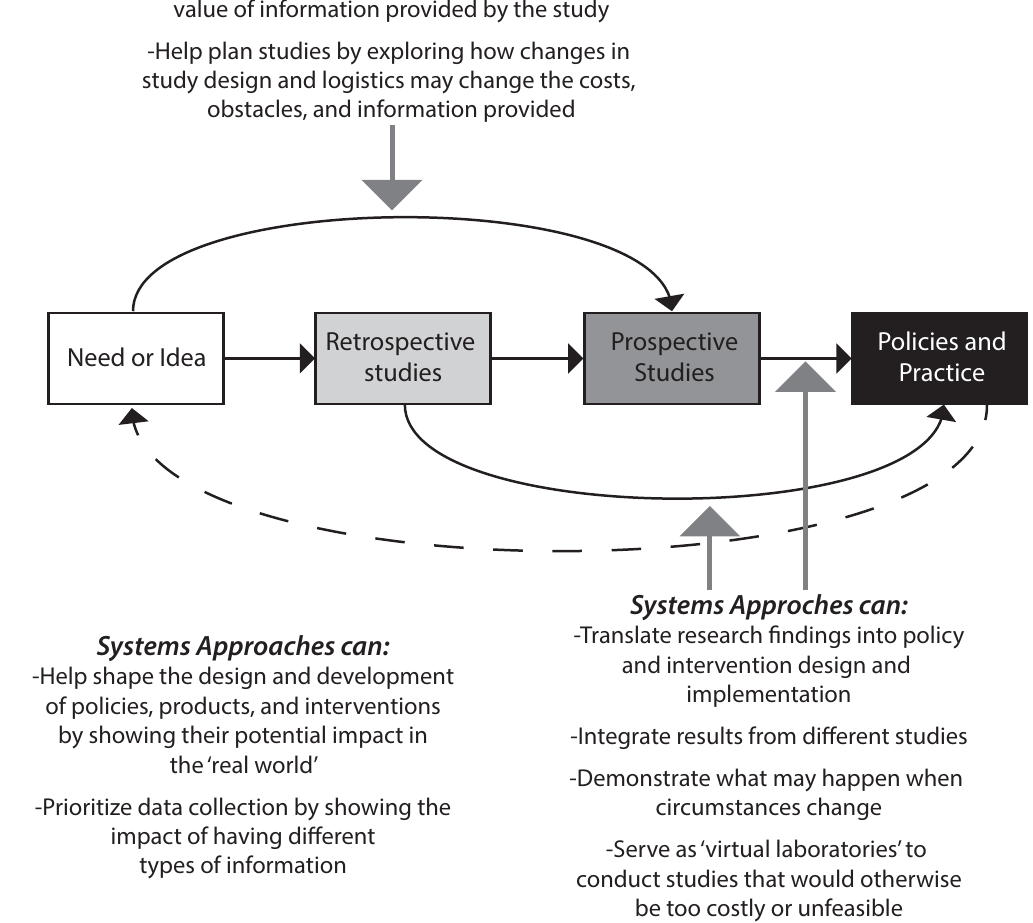
Fig 2. Systems modeling and approaches can and do occur at different points along the research path from idea inception to policy